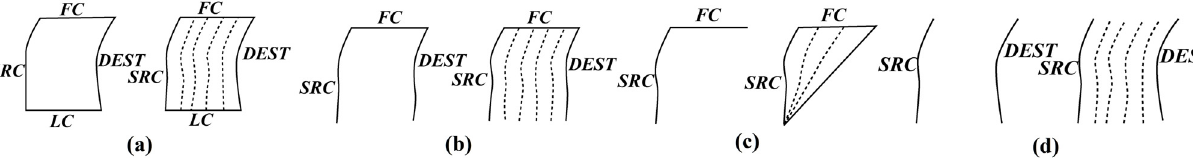
Figure 11. Four basic types of morphing methods (the dashed lines are the transition curves gener- ated by interpolation). ( a ) four-edge type; ( b ) three-edge type; ( c ) two adjacent-edge type; ( d ) two opposite-edge type.